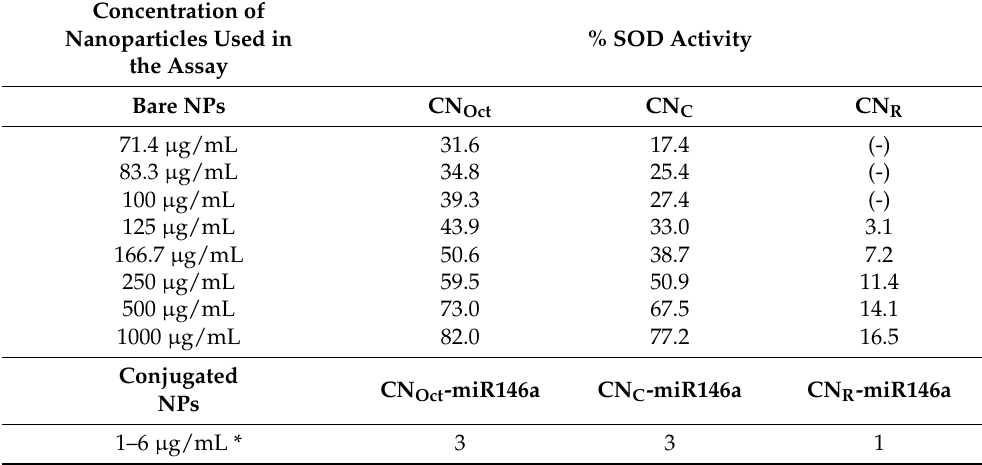
Table 2. The percentage of SOD activity of various concentration of pure different shape nanoparticles and miR conjugated different shape of